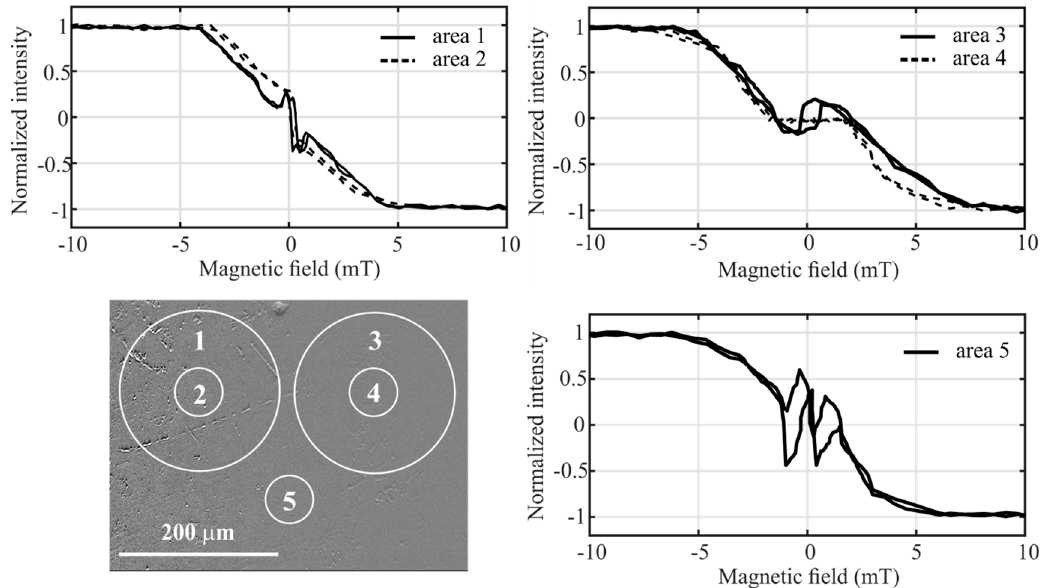
Figure 5. Magneto-optical hysteresis loops of amorphous Fe 80 Si 4 B 16 ribbon obtained by averaging over different surface areas denoted by white circles with diameters 200 µm (areas 1 and 3) and 60 µm (areas 2, 4, and 5).